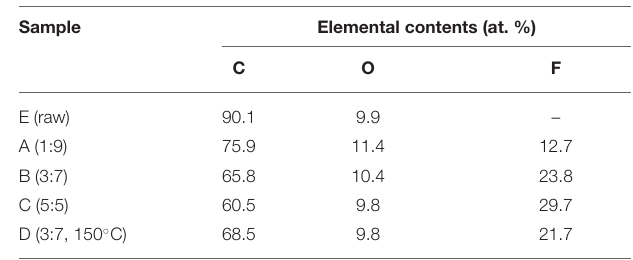
TABLE 1 | Surface elemental composition of the ACFs obtained from the XPS spectra.